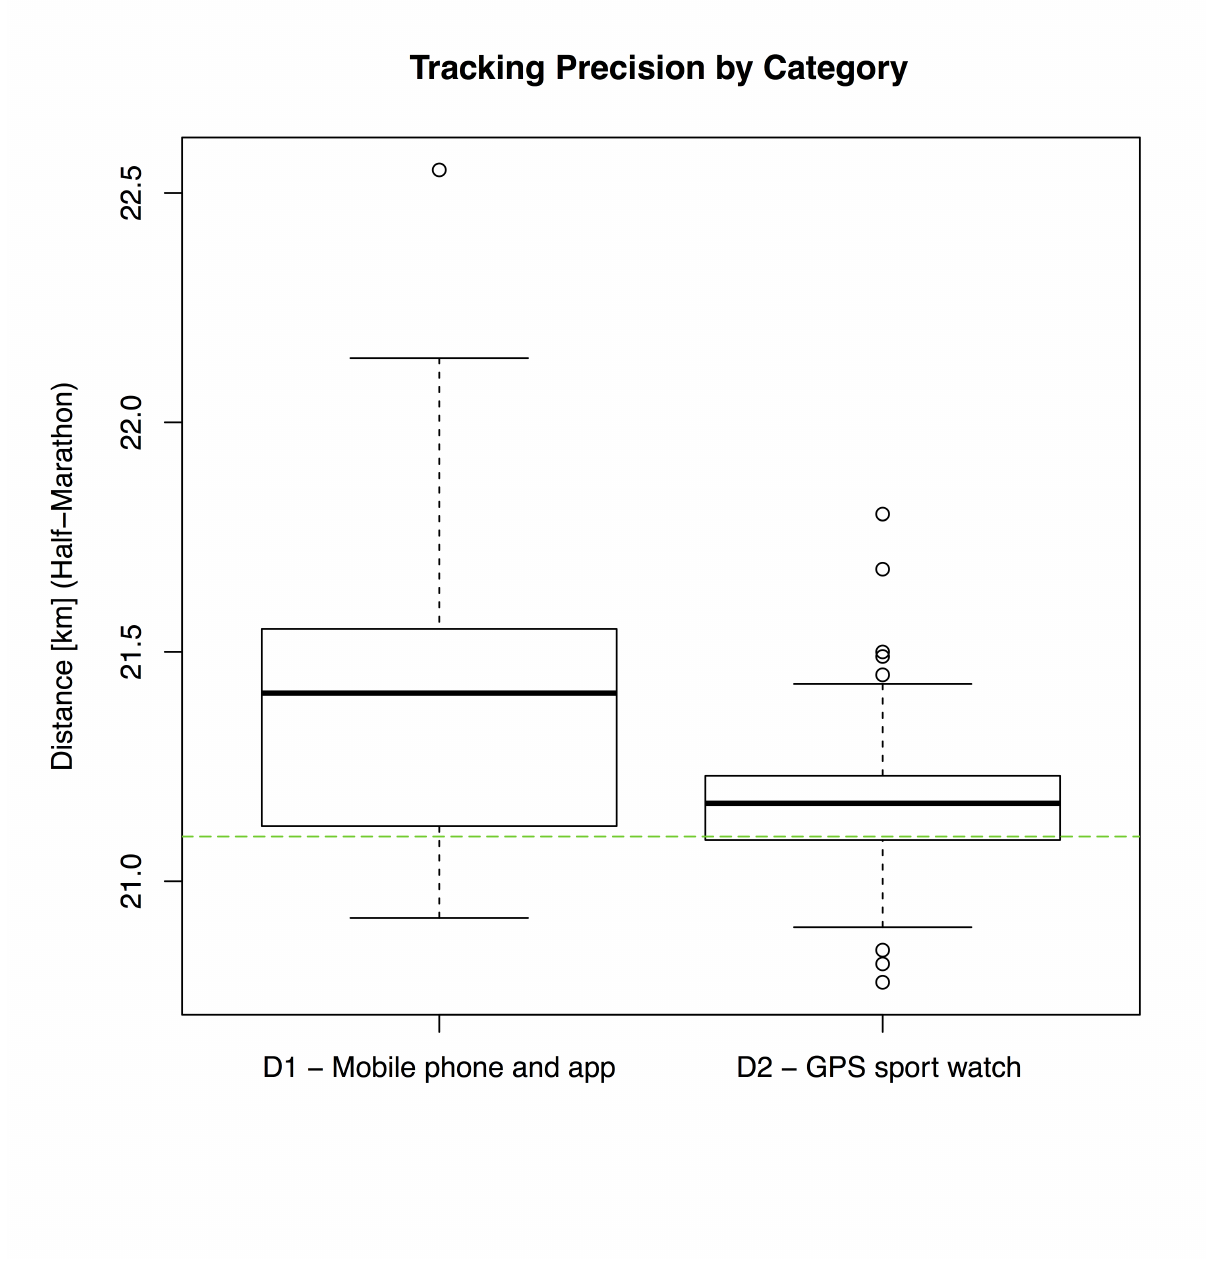
Figure 1. Box-and-whisker plot of recorded distances (half-marathon) by device category D1 (n=30) and D2 (n=179). The dashed line indicates the reference distance of 21.0975